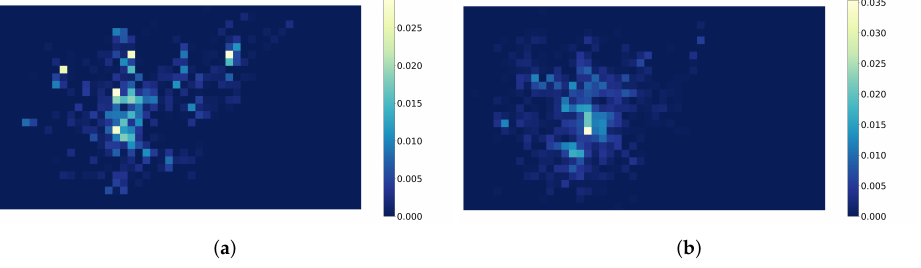
Figure 7. Frequency of ATCOs looking at each small unit in two scenarios. ( a ) Scenario in attention- guided mode with three aircraft; ( b ) scenario in automated mode with three